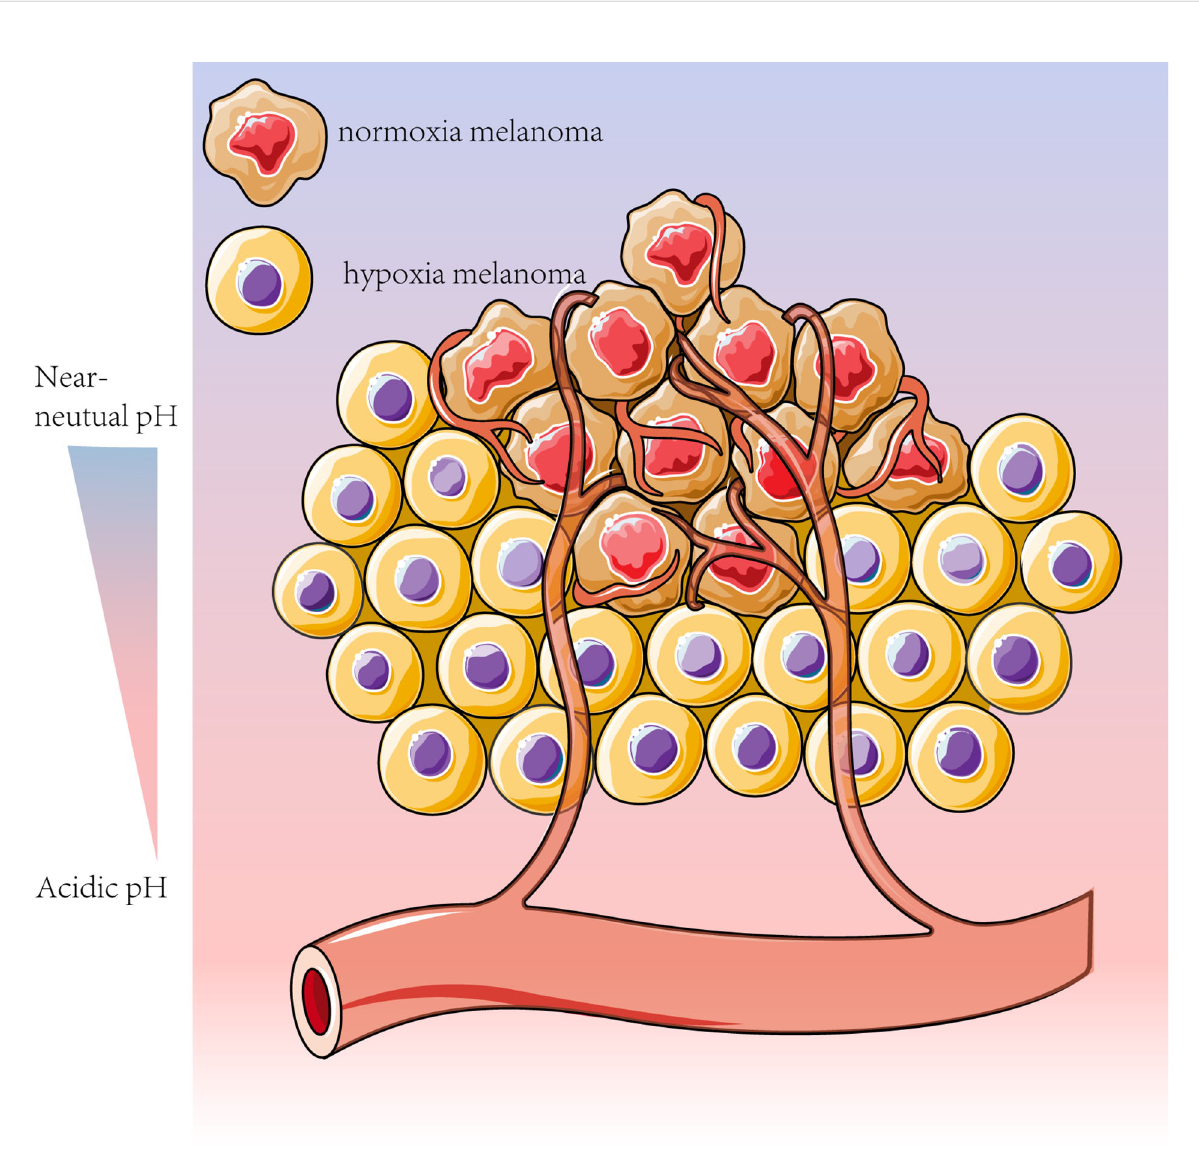
FIGURE 2 Melanoma cells can adapt their metabolism to the tumor microenvironment conditions, such as pH and oxygen content. To meet the high metabolic “ demand ” associated with melanoma dormancy, homeostasis and escape, the less oxygenated sites rely mainly on glycolysis, whereas the more vascularized tumors are more contingent on OXPHOS for energy production (14, 61). Based on this metabolic feature, melanoma cells can be divided into cells with enhanced glycolysis and inhibited OXPHOS under hypoxic conditions and other cells with adequate oxygen levels more dependent on OXPHOS